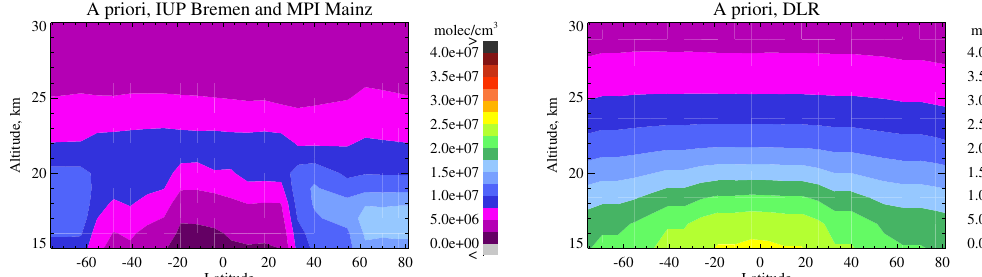
Fig. 20. A priori information used for the retrievals shown in Fig. 19